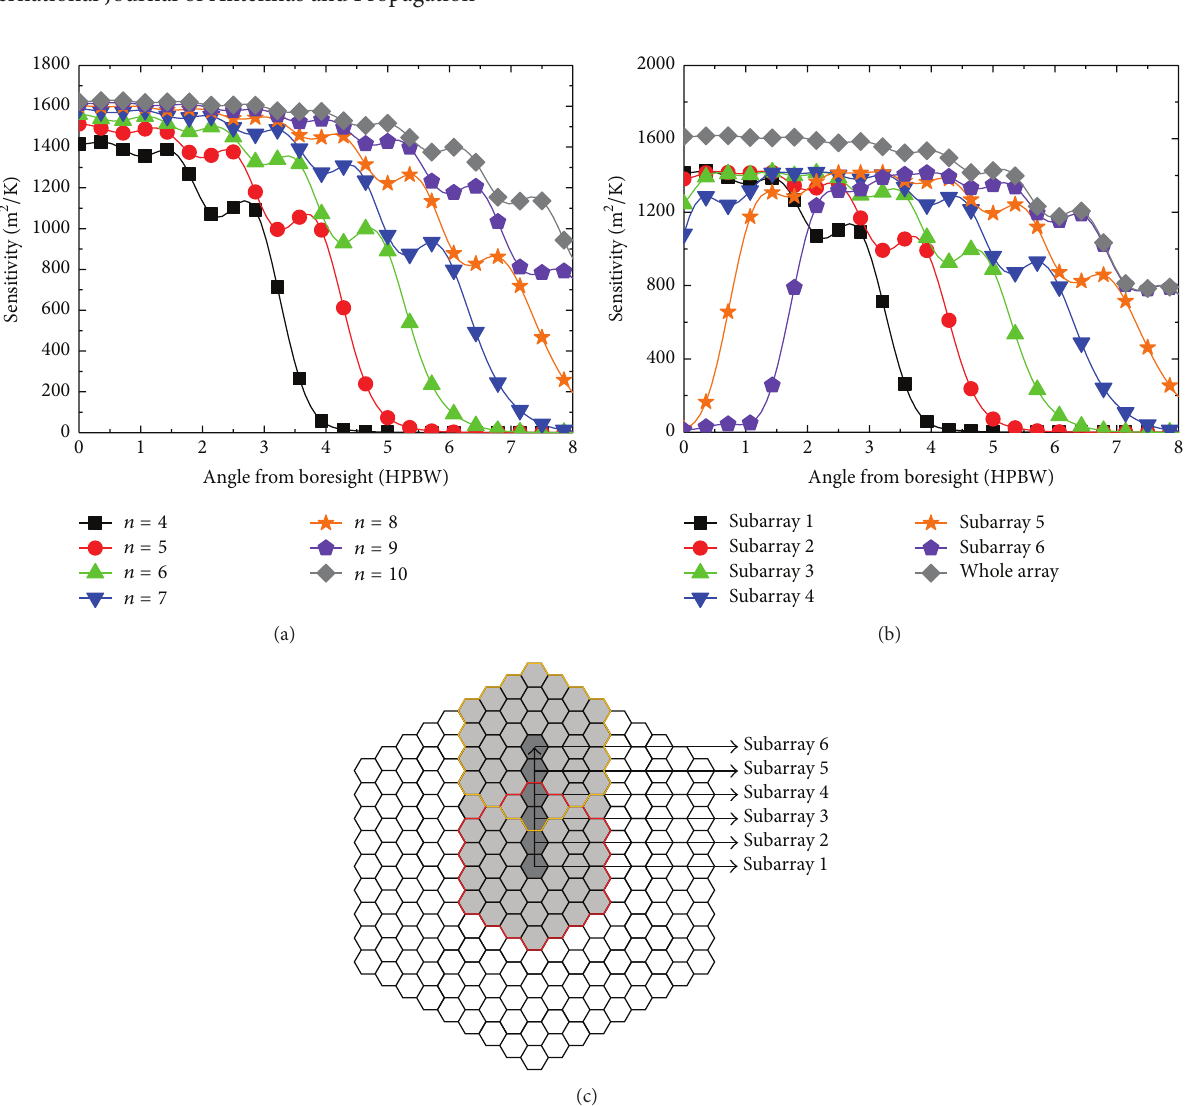
Figure5:Sensitivityversusdifferentnumbersofelementsanddifferentsubarrays.(a)Sensitivitywithdifferentnumberoffeeds.(b)Sensitivity with six 37-element subarrays at different locations and (c) six 37-element subarrays from center to the array